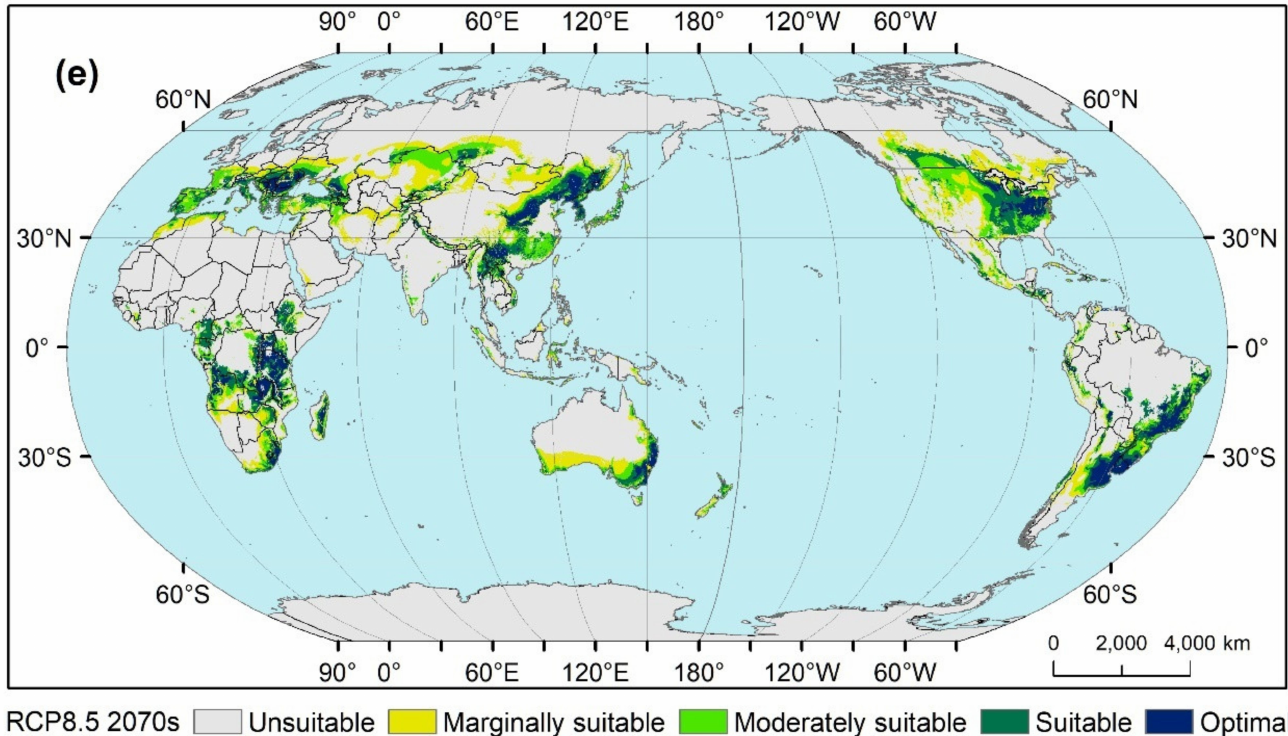
Figure 4. Areas worldwide suitable for maize: past and future (results from ensemble (CMIP5 GCMs) mode). ( a ) In the past (1970–2000); ( b ) in 2050s (2041–2060) under RCP2.6; ( c ) in 2070s (2061–2080) under RCP2.6; ( d ) in 2050s under RCP8.5; ( e ) in 2070s under RCP8.5. RCP: representative concentration